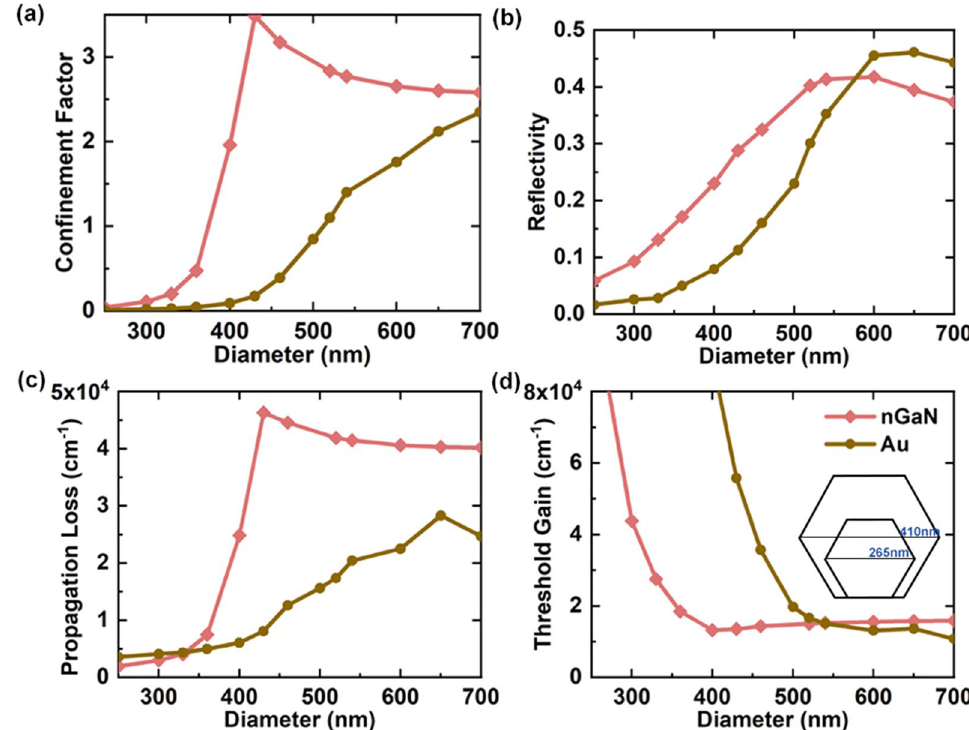
Fig. 5 Diameter-dependent mode confinement factor (CF) a , end facet reflectivity b , propagation loss c, and threshold gain d for Au-based (gold lines) and nGaN-based (red lines) NW lasers. The inset in d provided a physical intuition for the cutoff diameter’s